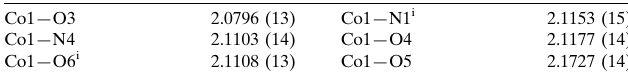
Selected geometric parameters (A˚ , (cid:3) ).